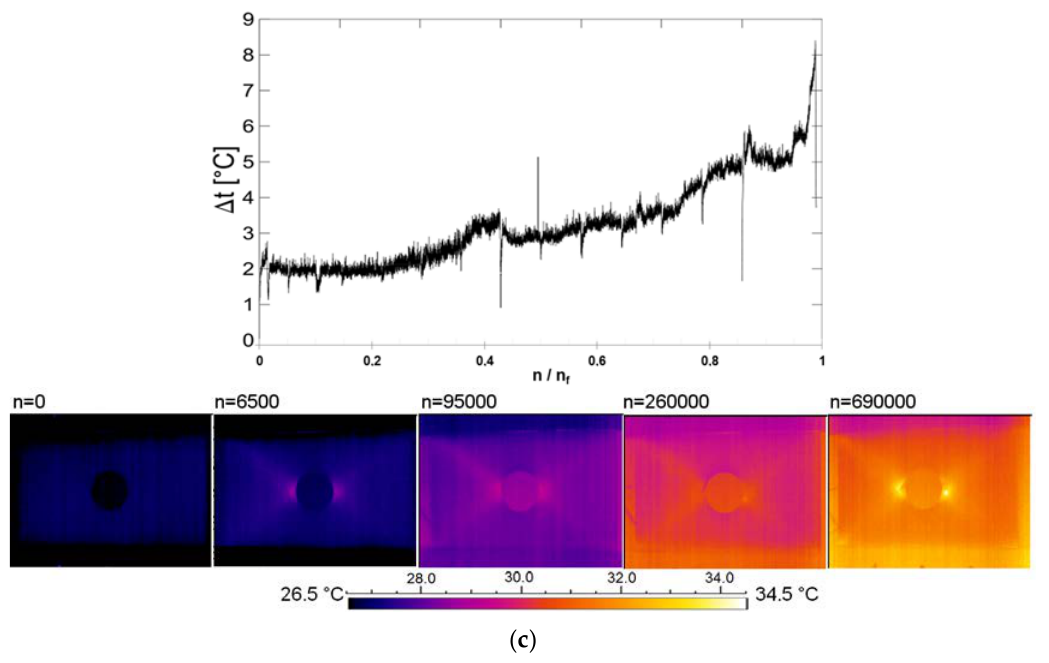
Figure 7. Rise of temperatures Δt at the edges of holes s: ( a ) the vertical elliptical hole (Δ t max = 8.2 °C, ( b ) the horizontal elliptical hole (Δ t max = 5.8 °C, ( c ) the circular hole (Δ t max = 8 °C).